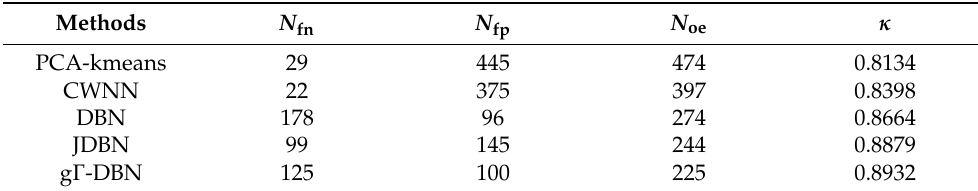
Table 5. Quantitative evaluation of the Coastline data